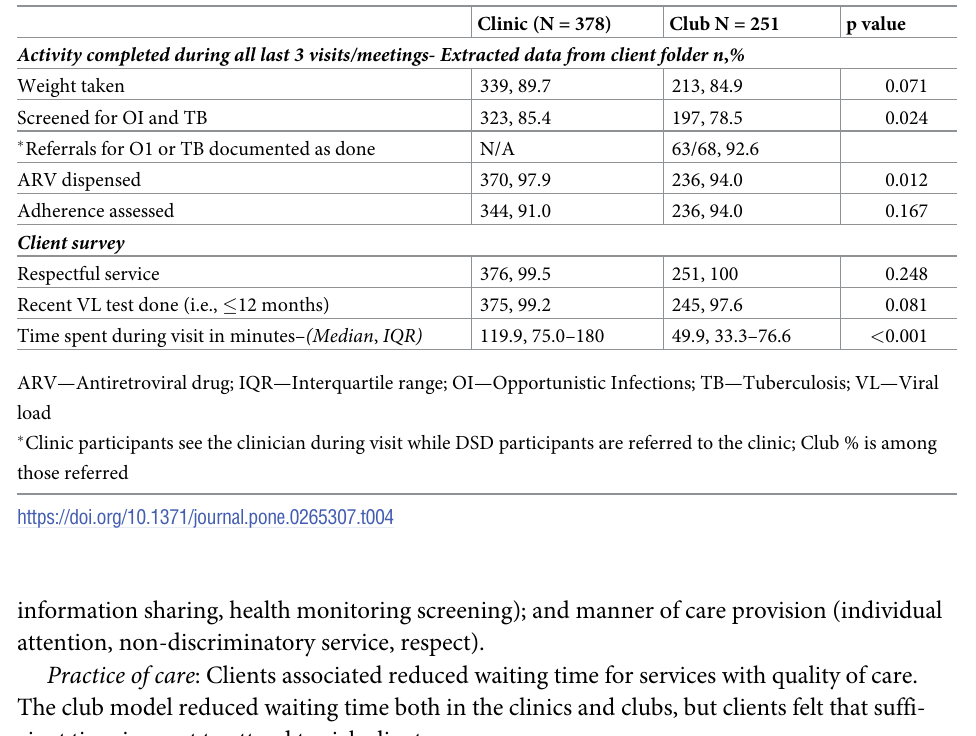
Table 4. Process of care: Clients perspective and HCW care